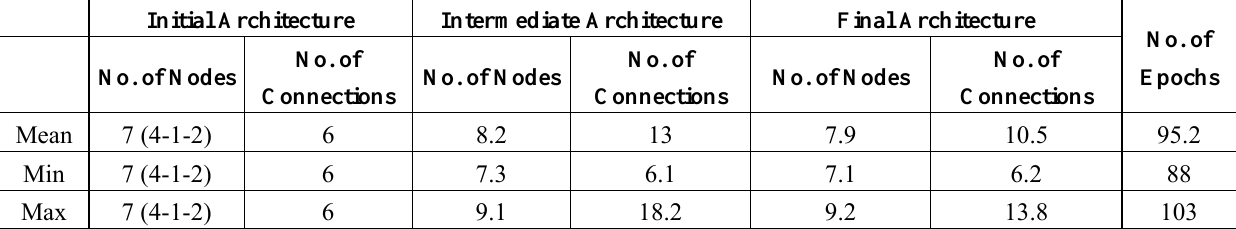
Table 7. ANN architectures and the training epochs for the golf playing